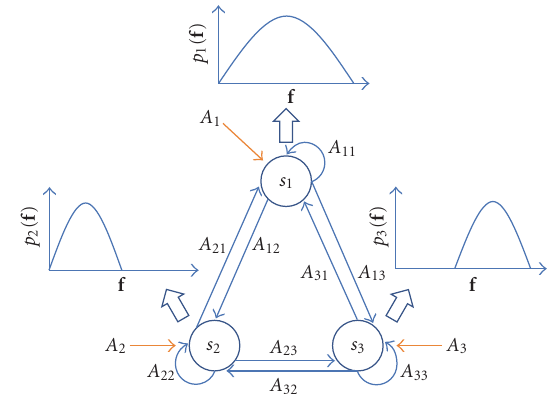
Figure 2: An example of a 3-state HMM with each state emitting a 1D feature vector f